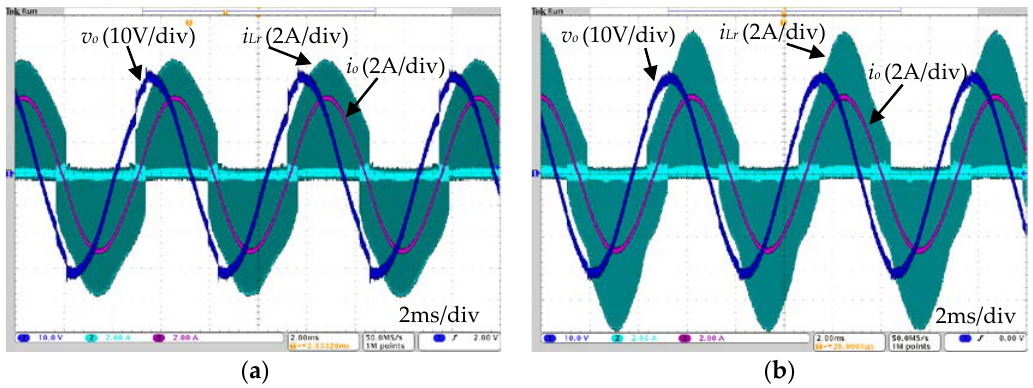
Figure 11. The current and voltage waveforms of ARSI with conventional control and proposed control: ( a ) conventional control and ( b ) proposed control.